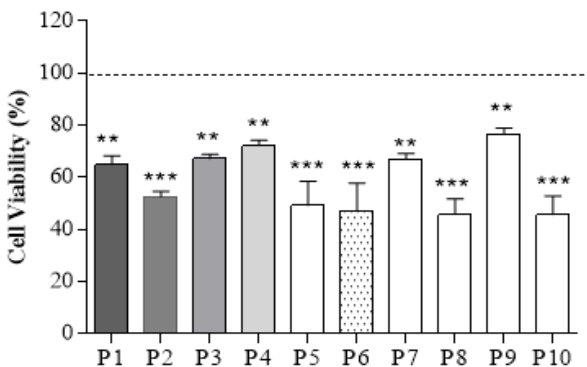
Figure 12. Cell viability of beta pancreatic cells. MTT assay results showing the percentage of viable cells on P1 to P10 samples after a culture period of 48 h. “**, ***” denotes a statistically significant difference ( p < 0.05) in cell number concerning the tissue culture plastic (TCP). Data points represent mean ± SD ( n = 3).